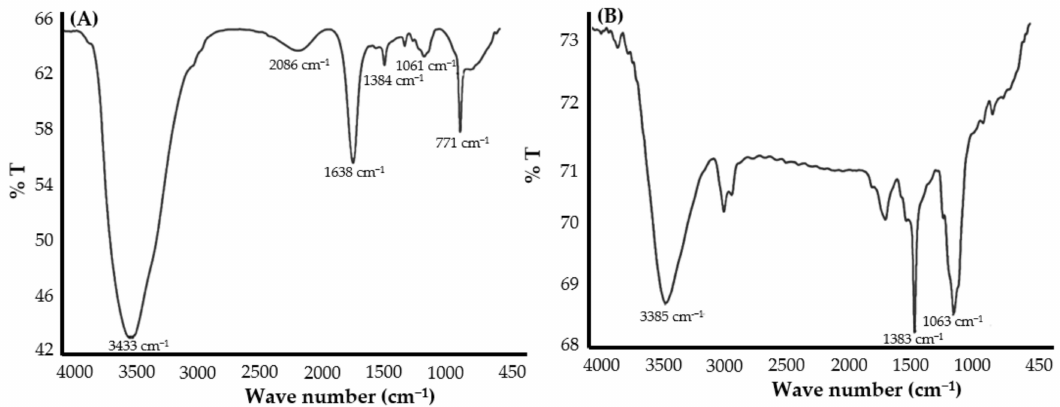
Figure 5. FTIR spectra of ( A ) pure DFX and ( B )